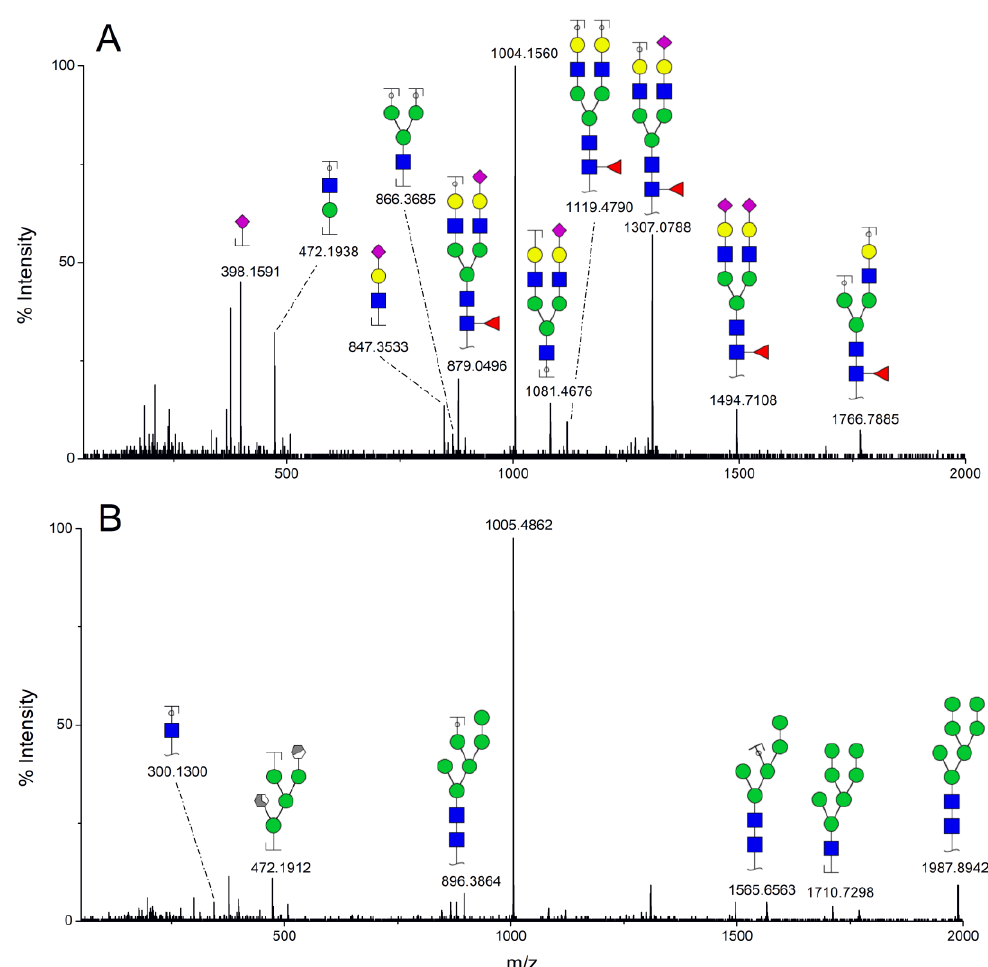
Figure 2. MS/MS spectra of permethylated N-glycans obtained in a reverse-phase LC-MS/MS analysis of a colon cancer patient, ( A ) HexNAc4Hex5Fuc1NeuAc2 (precursor mass [M + 3Na] 3+ = 1004.1560 Da, Nr. 58 in Table 2) and ( B ) HexNAc2Hex7 (precursor mass [M + 2Na] 2+ = 1005.4862 Da, Nr. 17 in Table 2). Data interpretation was performed automatically by the software GRITS.